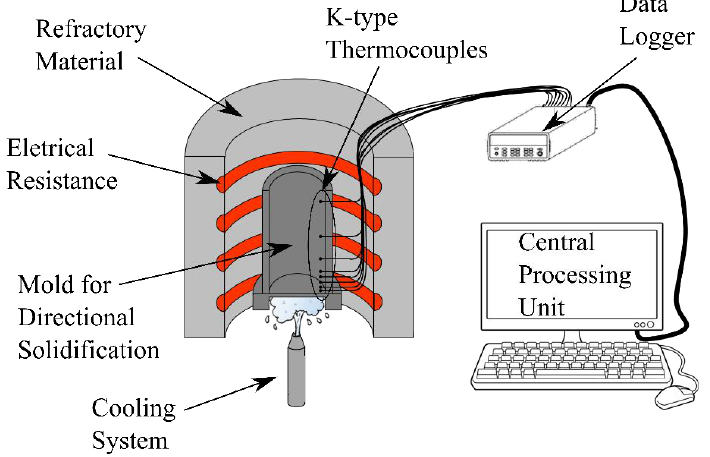
Figure 1. Schematics of the vertical upward directional solidification device.